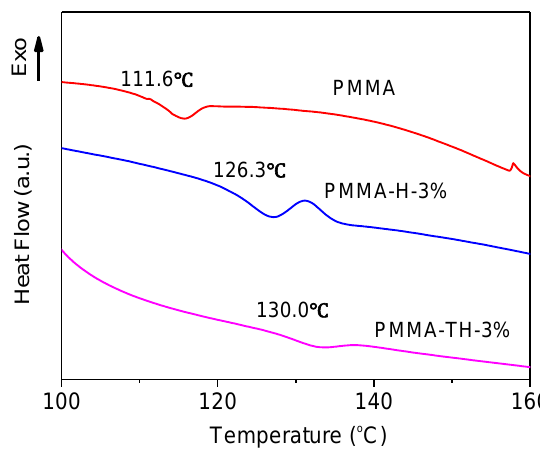
Figure 8. DSC curves of PMMA and PMMA/reactive halloysite nanocomposite.